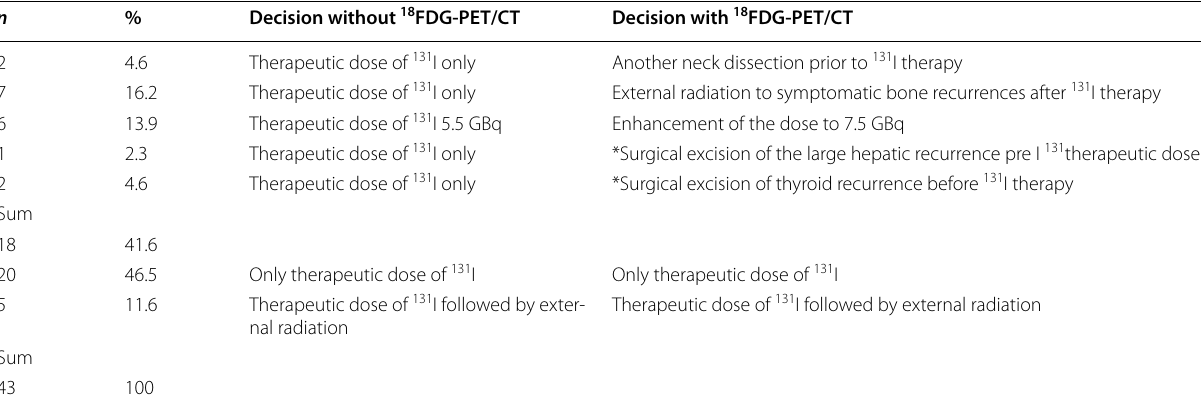
*Patients did not undergo surgical